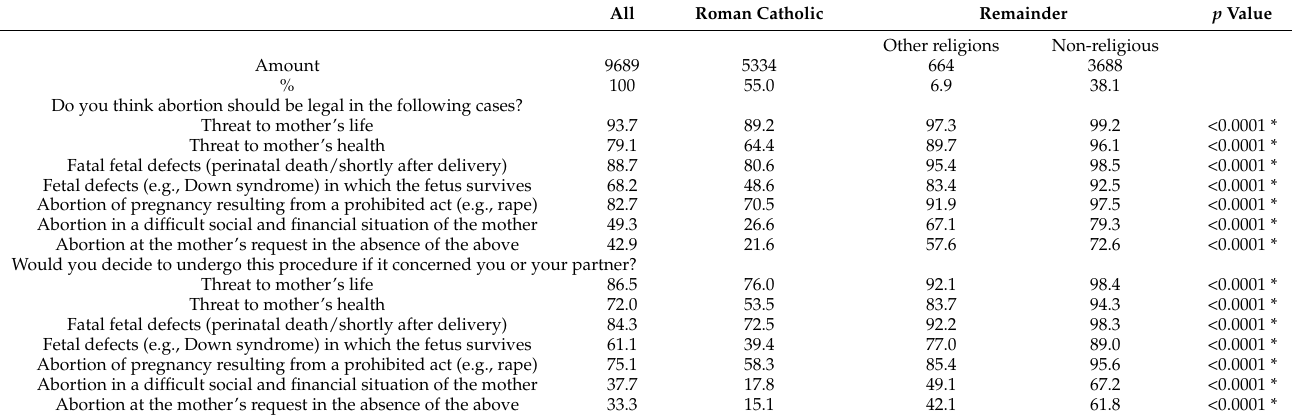
Table 2. Attitude to abortion regarding Roman Catholic religion. All data contained in table are presented as percentage [%] of answers YES for each